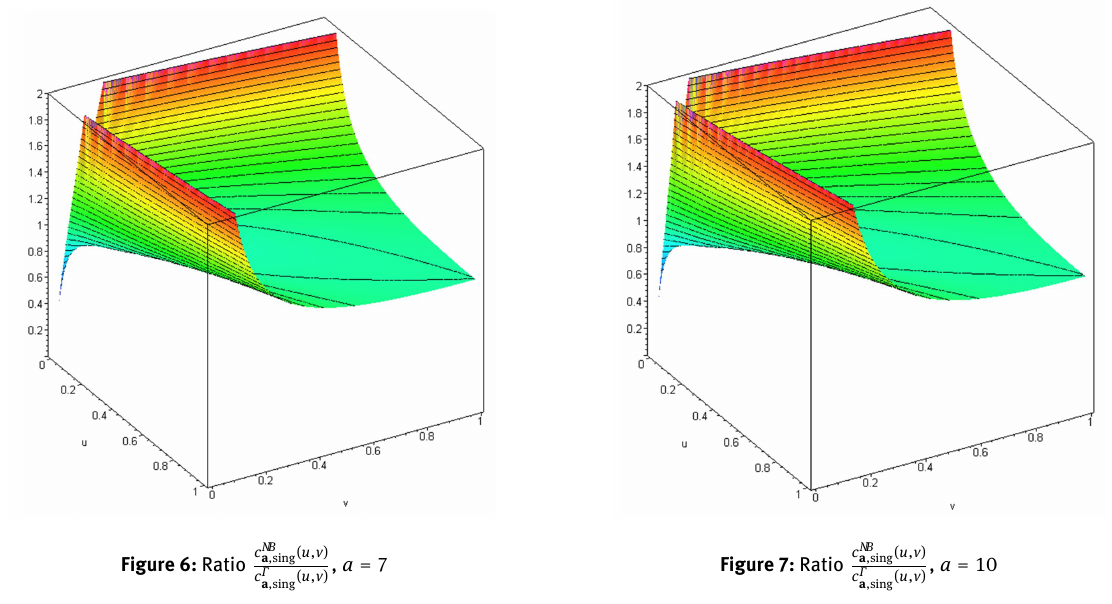
c NB a ,sing ( u , v ) , a = c Γ a ,sing ( u , v )